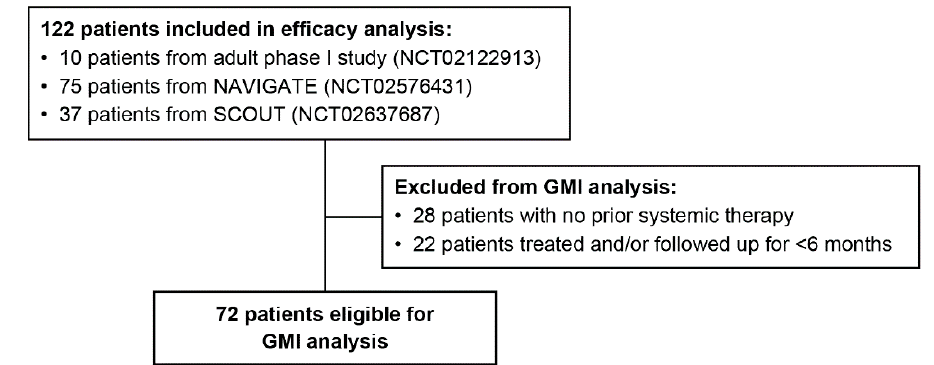
Figure 3. Growth modulation index (GMI) analysis set.